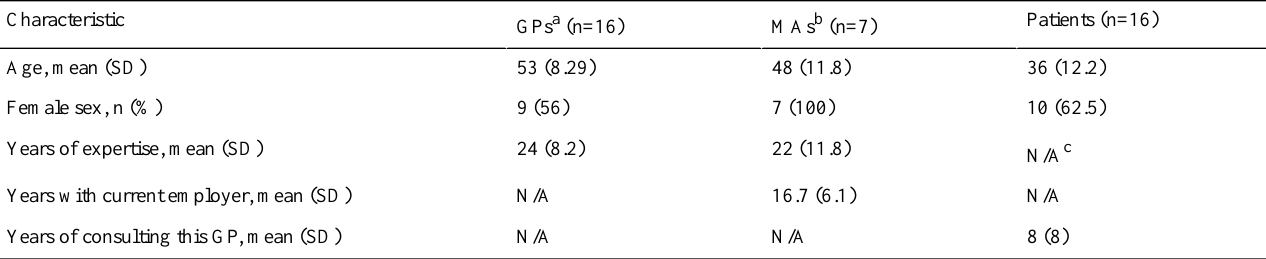
Table 2. Sociodemographic characteristics of the interview participants in this study (N=39).